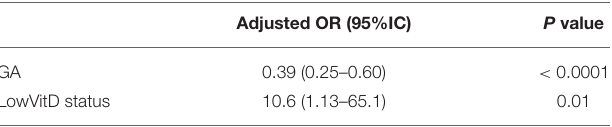
TABLE 3 | Regression analysis: factors associated with the combined outcome of death or mechanical ventilation on the 7th day after birth (death or MV DOL7).